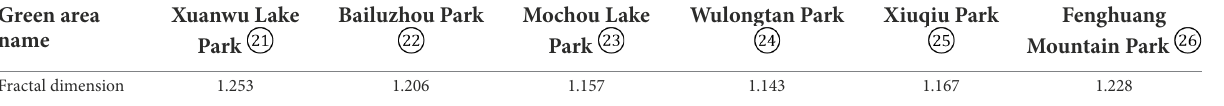
TABLE 6 Fractal dimension statistics of historical and cultural water body. Green area name